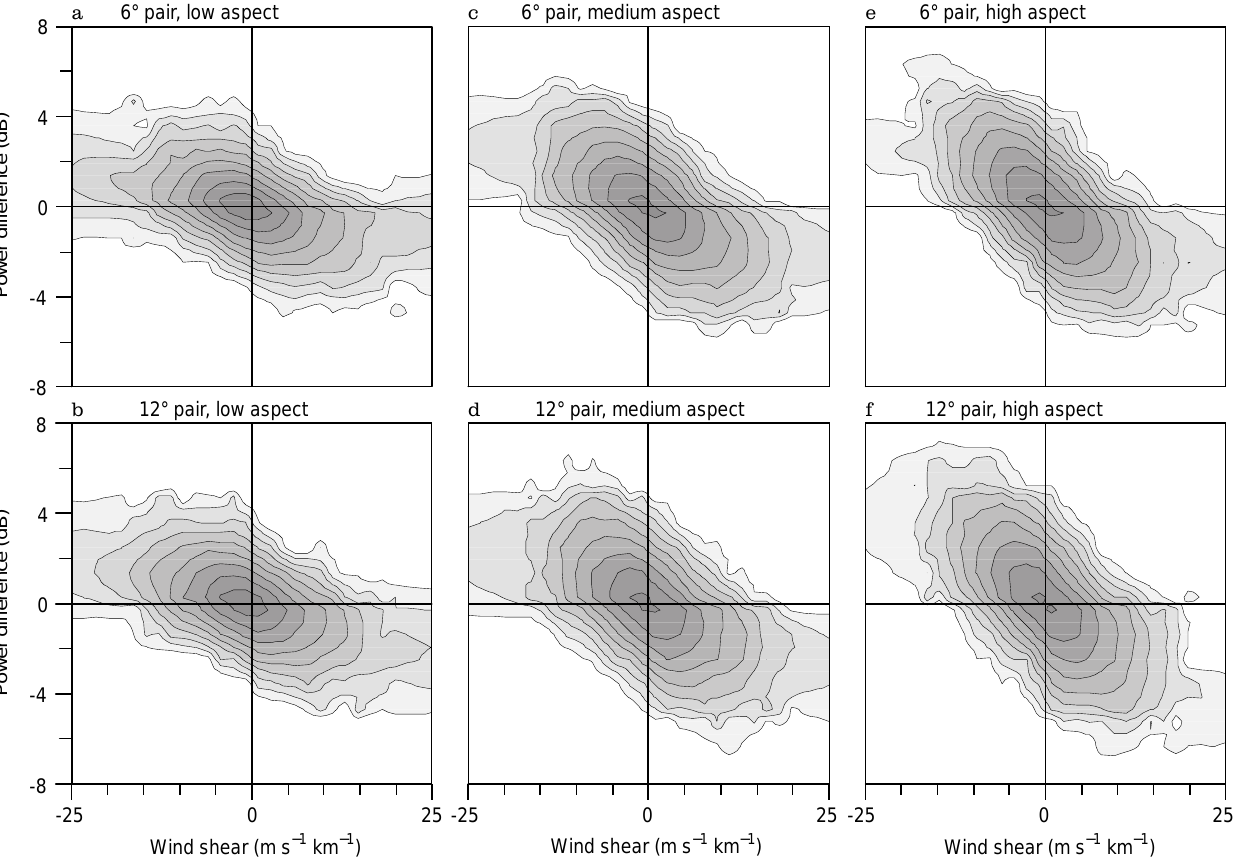
sensitivity. Data points are counted in bins of 1 dB (cid:2) 1 m s (cid:255) 1 km (cid:255) 1 ; the outer contour line corresponds to 2 points per bin, and the density of points doubles at every inner